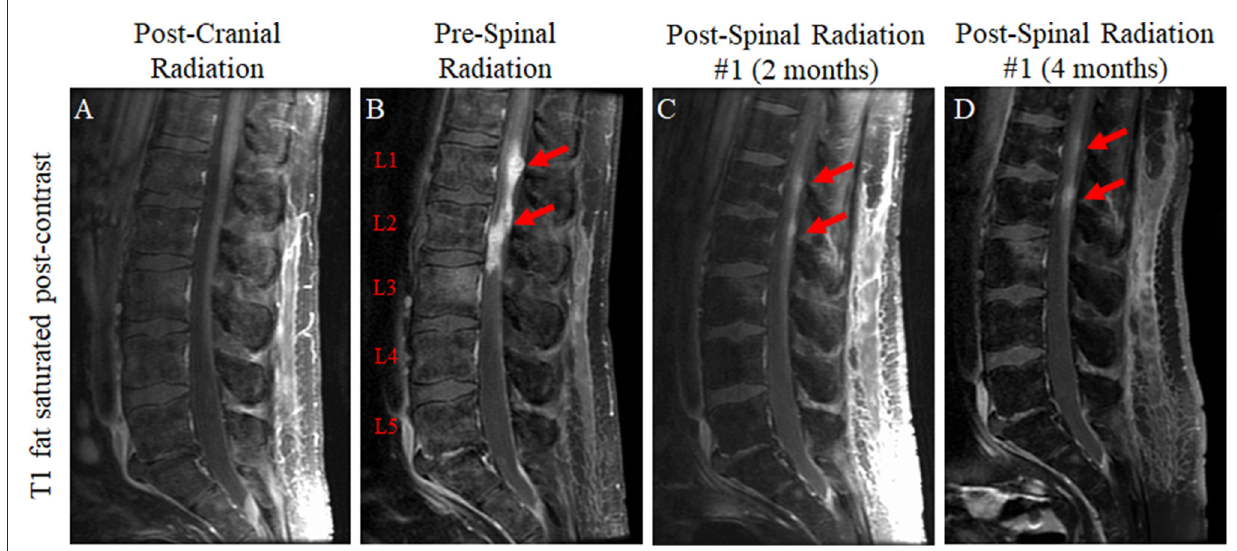
FIGURE4 T1-weighted fat-saturated post-contrast sequences of the lumbar spine for the patient in case 2 immediately following radiation to the brain lesion (A) ; 7 months later following the development of new lower back pain which revealed leptomeningeal drop metastases at the level of T12 extending to the terminus of the thecal sac (T12 to L3 predominant lesions represented graphically) (B) ; approximately 2 months after the completion of 30Gy of radiation in 10 fractions to T10-S4 with a significant reduction in lesion size (C) ; and approximately 4 months after the completion of spinal radiation (D)